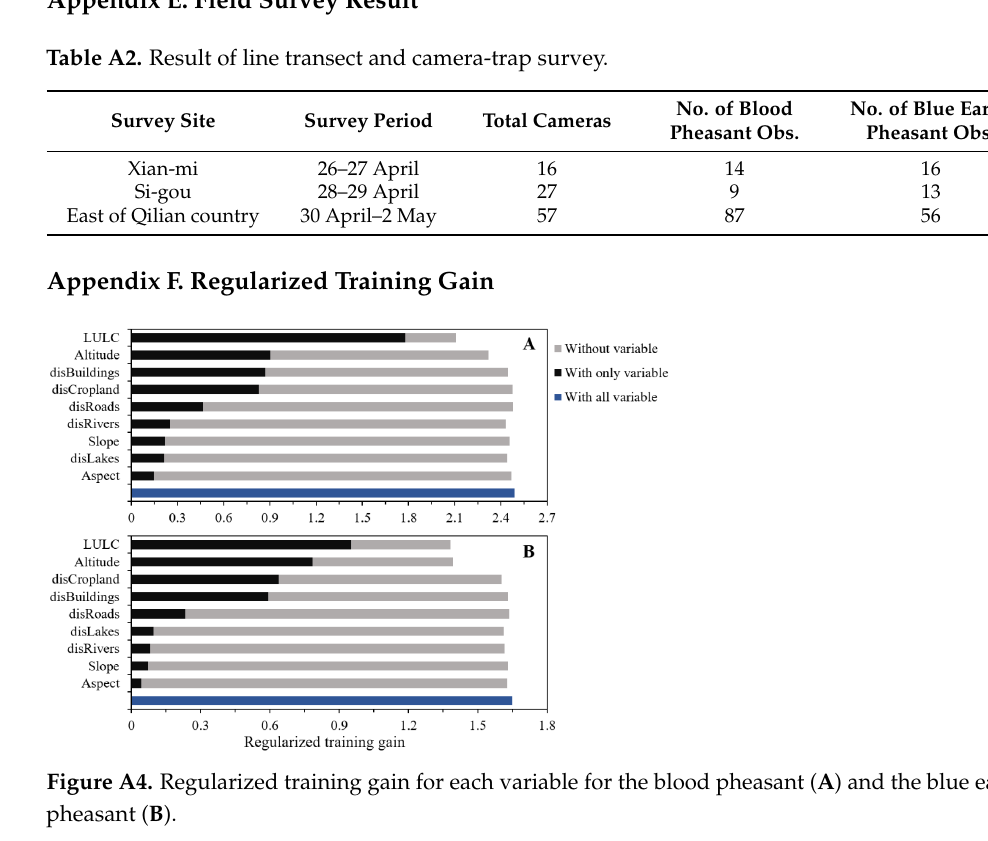
Table A1. Source of occurrence data used for the distribution modeling of the blood pheasant and the blue eared pheasant.